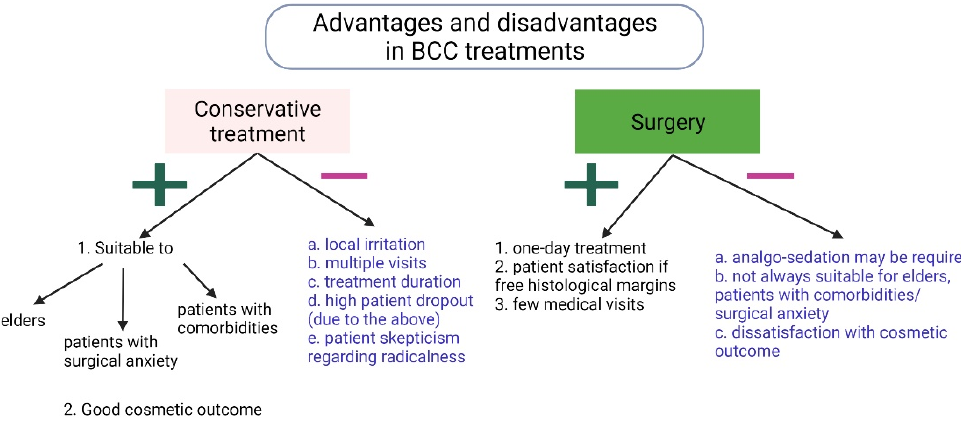
Figure 5. Advantages and disadvantages of conservative and surgical treatments for BCC.